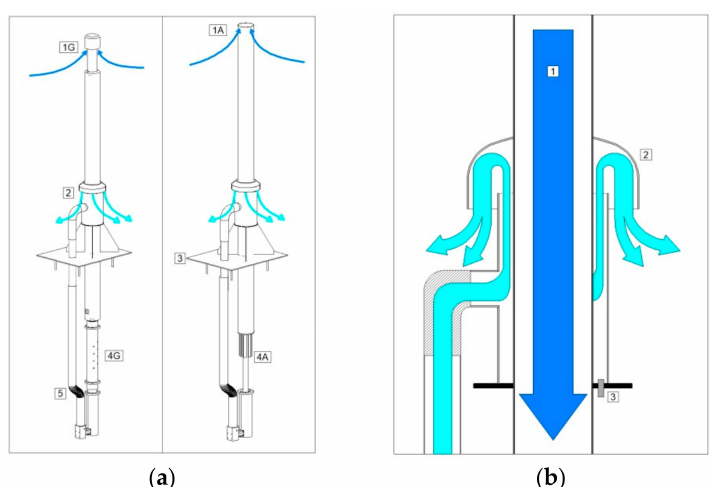
Figure 1. ( a ): air intake systems for RGs (left) and AEs (right). The numbers in the technical diagram denote: air inlet (1), air exhausts (2), flanges for mounting on the roof (3), manifolds for the connection of tubing to analyzers (4), high-velocity fan (5). ( b ): details of the air streams in the proximity of the air exhaust. Dark and light arrows represent the air stream at the inlet and at the exhaust of the intakes, respectively.